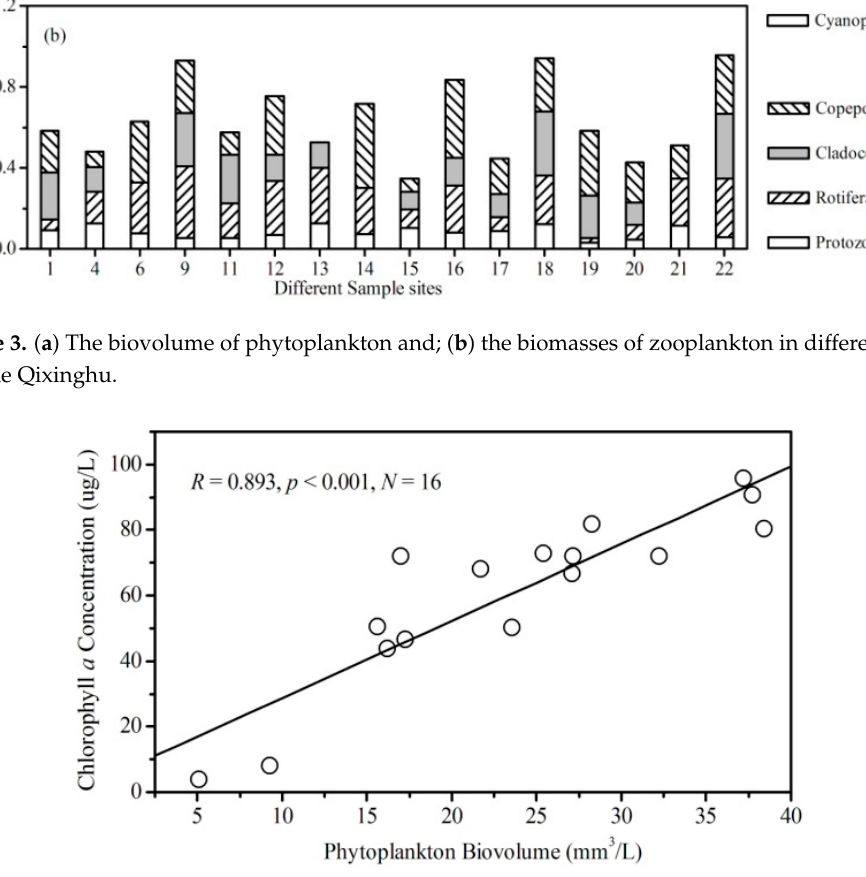
Figure 4. The relationship between phytoplankton biovolume and chlorophyll a in Lake Qixinghu.